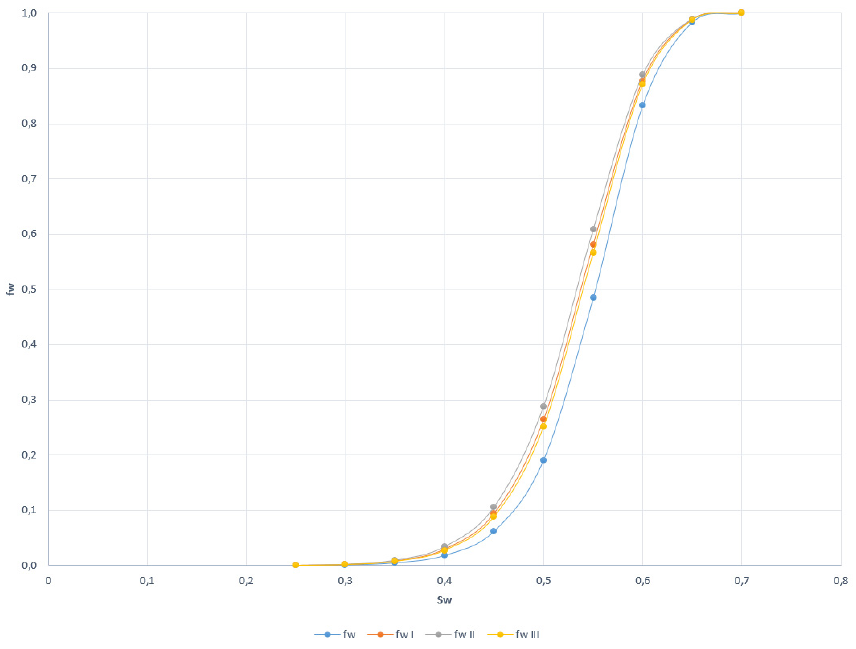
Figure 7. Calculated Buckley–Leverett curve of oil displacement.